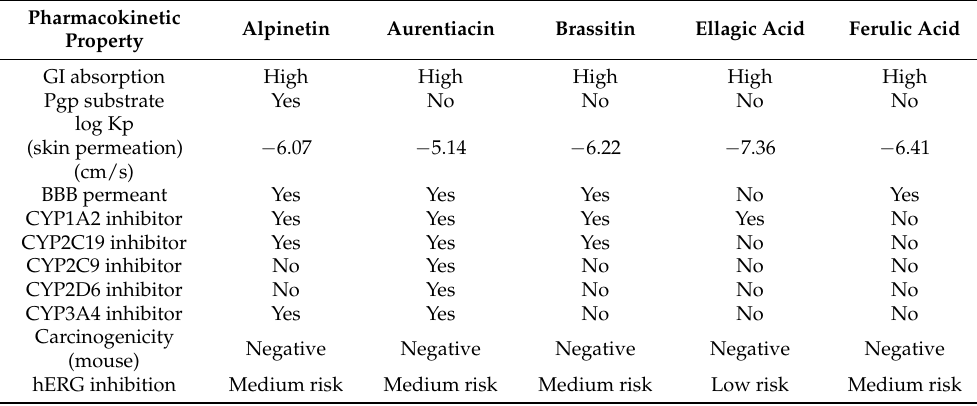
Table 6. ADMET-predicted properties of possible ligands in